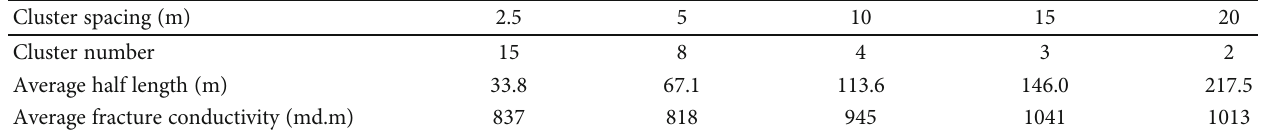
Table 3: Parameters of the hydraulic fracture geometries under di ff erent cluster spacings.